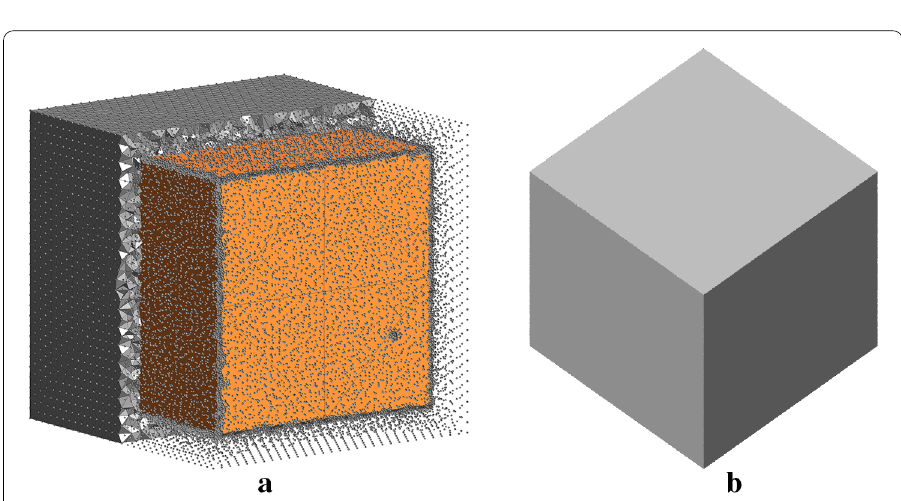
Fig. 26 Approximation of a cube immersed into a refined background mesh. a Section view of the refined background mesh with immersed cube (nodes of the entire background mesh are highlighted). b Resulting surface approximation within the refined background mesh